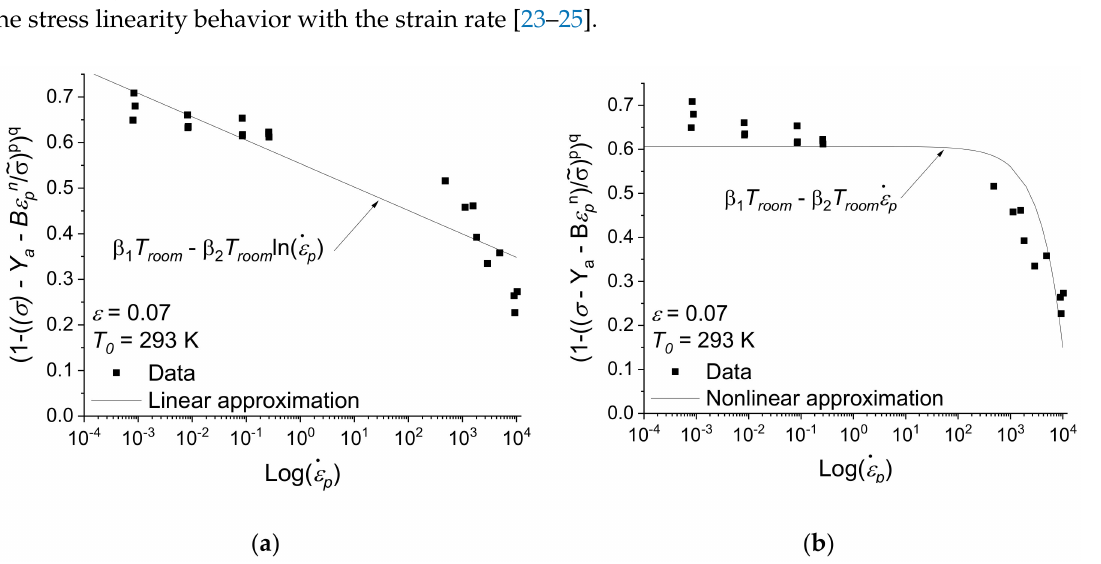
Figure 10. Determination of β 1 and β 2 : ( a ) initial approach, linear approximation β 1 T room − (cid:0) (cid:1) ˙ ε p β 2 T room ln ; ( b ) new approach to introduce strain rate sensitivity, approximation β 1 T room − β 2 T room ˙ ε p